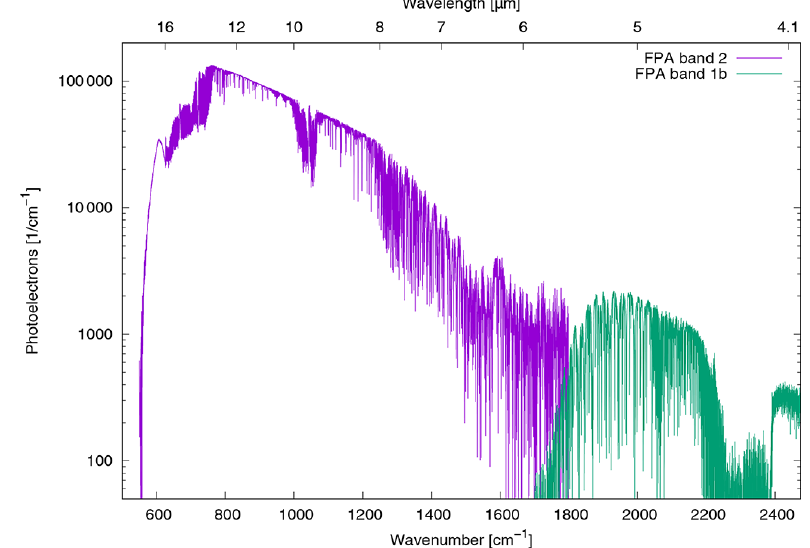
Figure 4. Simulated JPL GEO-IR Sounder spectrum in the VLWIR, LWIR, and MWIR domains. Note the logarithmic